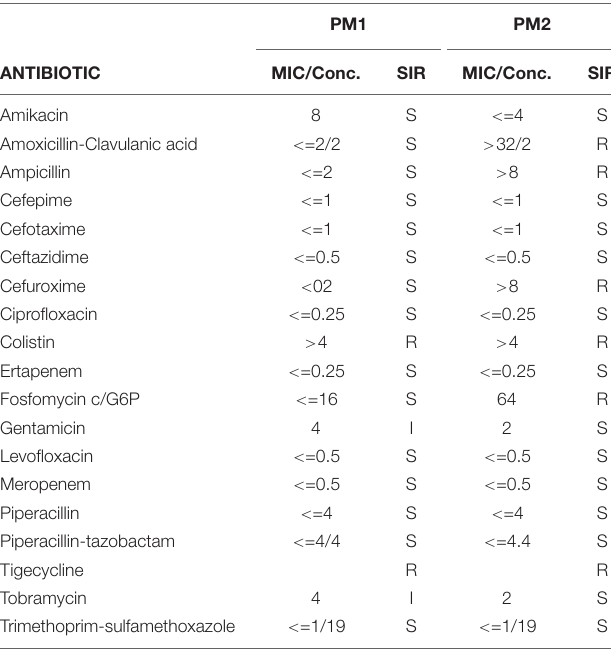
susceptible (S), intermediate (I), or resistant (R).